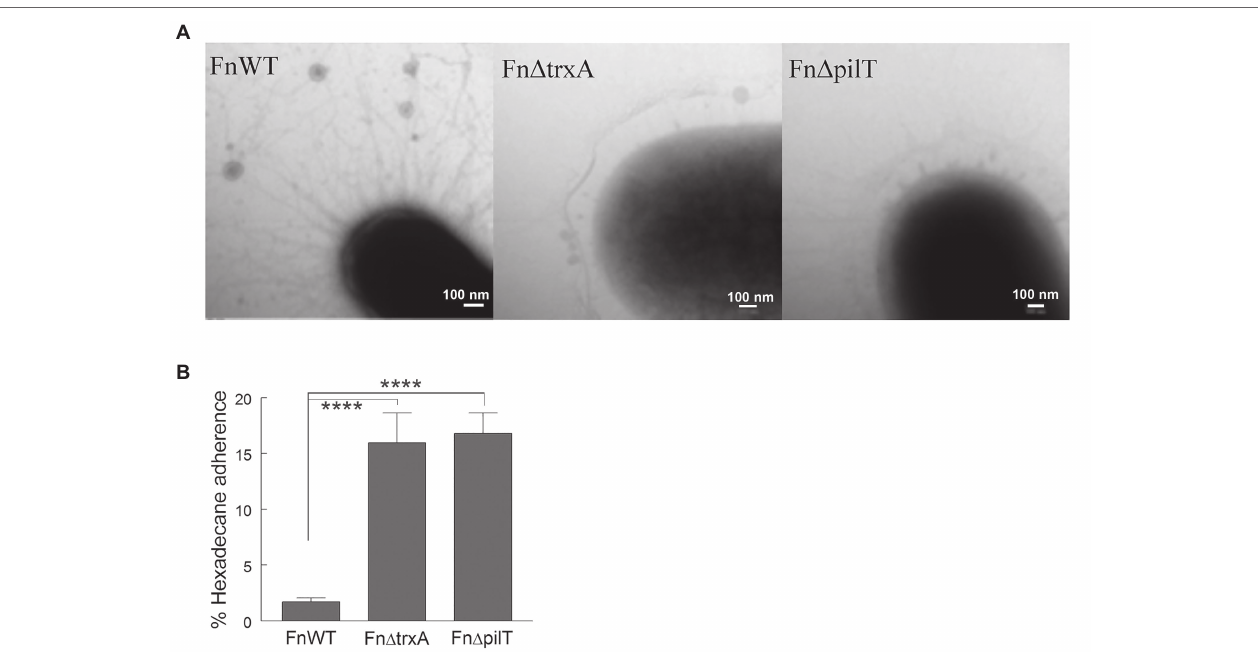
FIGURE 5 | Changes in cell surface hydrophobicity are associated with lack of type IV pili. (A) Negatively-stained transmission electron microscopy images of Francisella novicida wild type (FnWT), Fn Δ trxA, and Fn Δ pilT. (B) Adherence to n-hexadecane by Fn, Fn Δ trxA, and Fn Δ pilT. Statistical differences were determined by one-way ANOVA with Holm-Sidak correction for multiple comparisons (**** p <